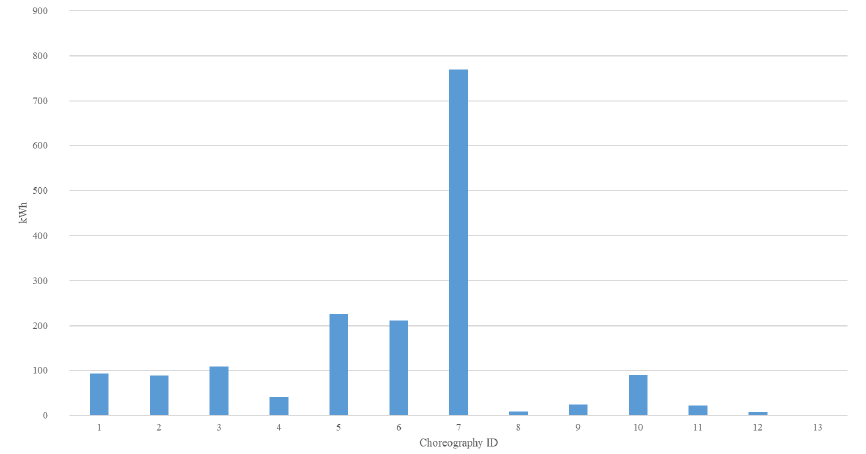
Figure 2. Overall consumption, in kWh, per